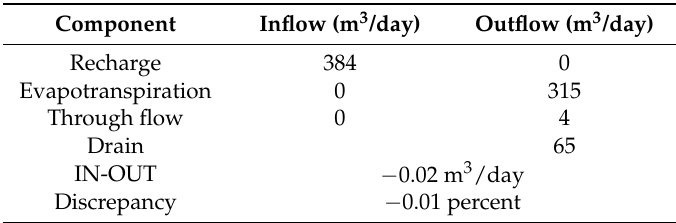
Table 2. Scenario 1 Steady State Modeled Mass Water Balance Summary.